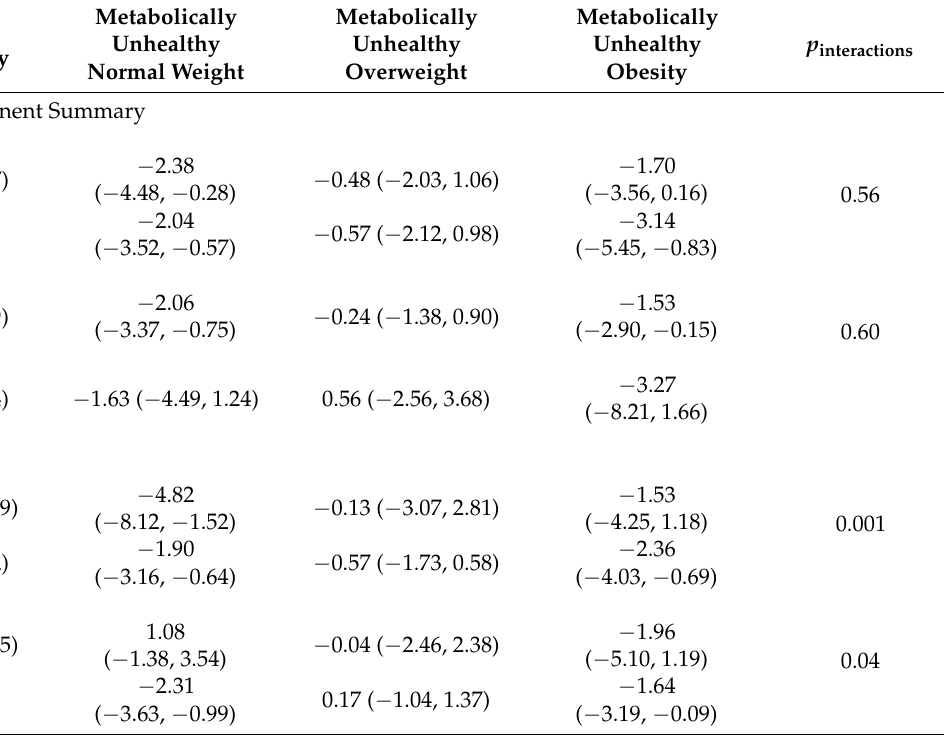
Metabolically Unhealthy Normal Weight